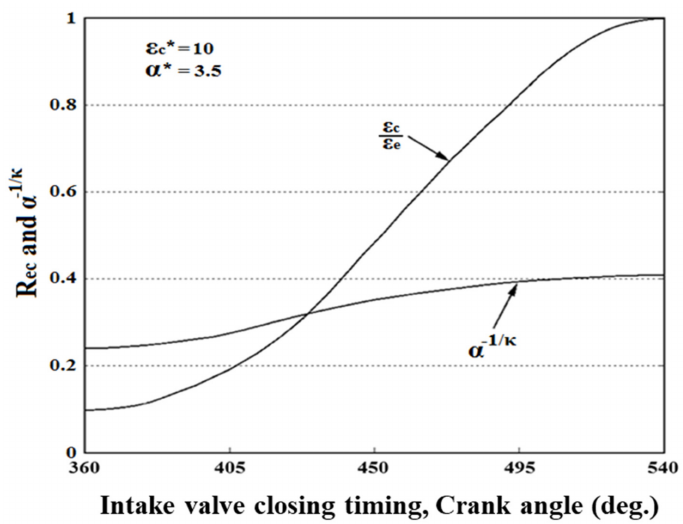
Figure 2. Compression expansion ratio, R ec , and α − 1 κ as functions of intake valve closing timing.